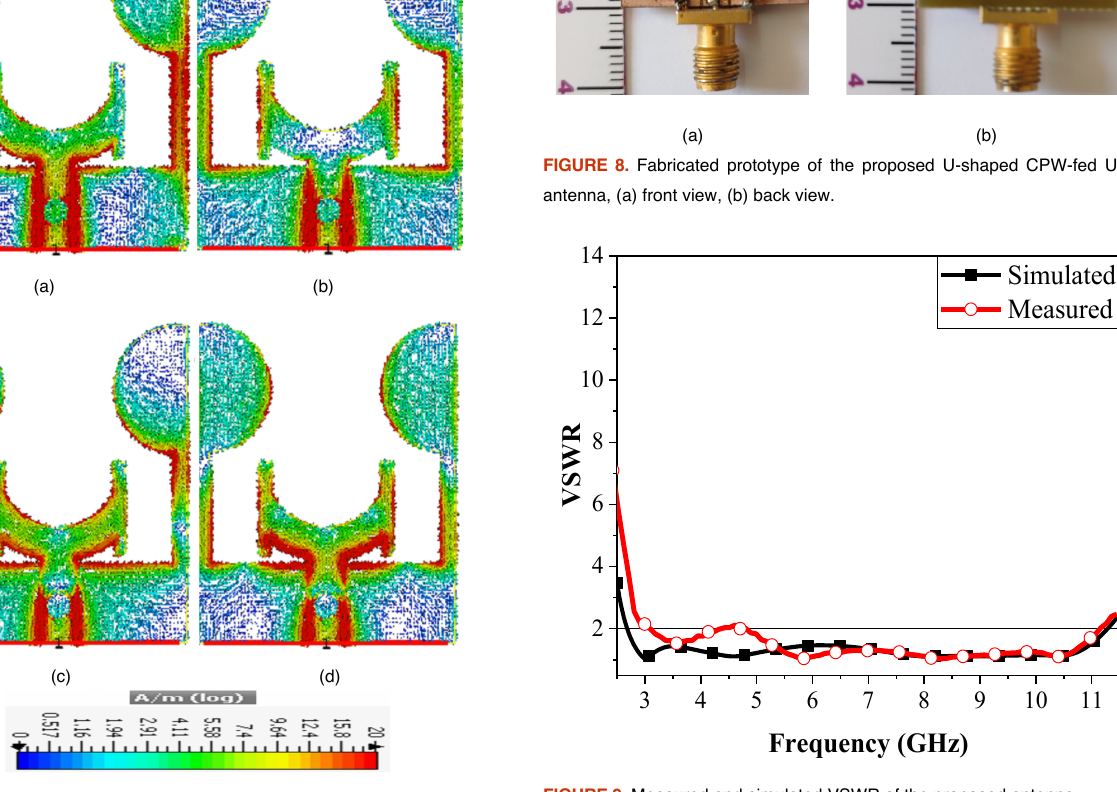
FIGURE 9. Measured and simulated VSWR of the proposed